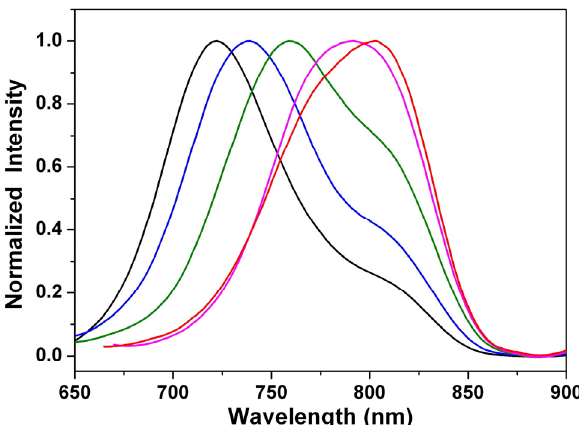
Figure 5. Normalized emission spectra of 2a in cyclohexane (black line), diethyl ether (blue line), ethyl acetate (olive line), dichloromethane (pink line), and acetonitrile (red line).